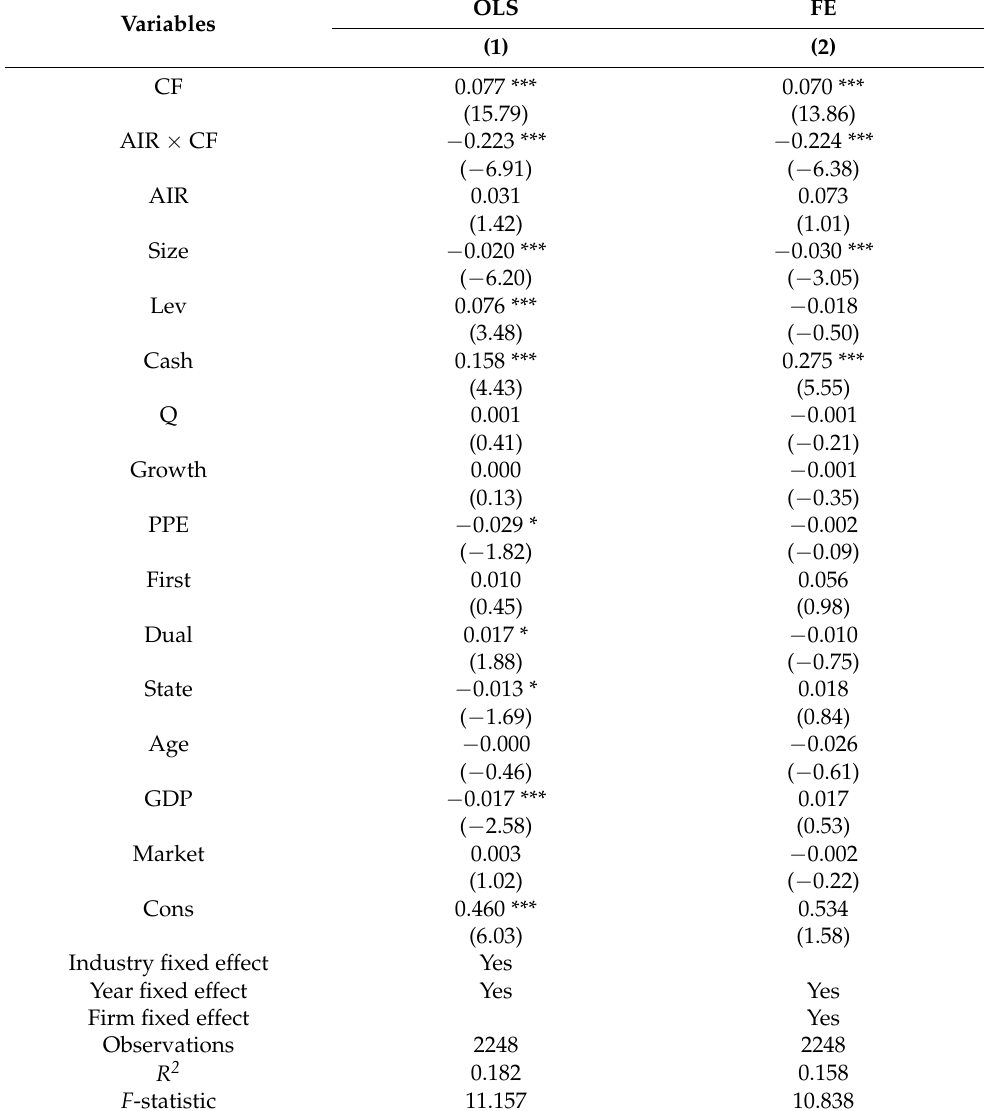
Table 9. Robustness test using OLS and FE